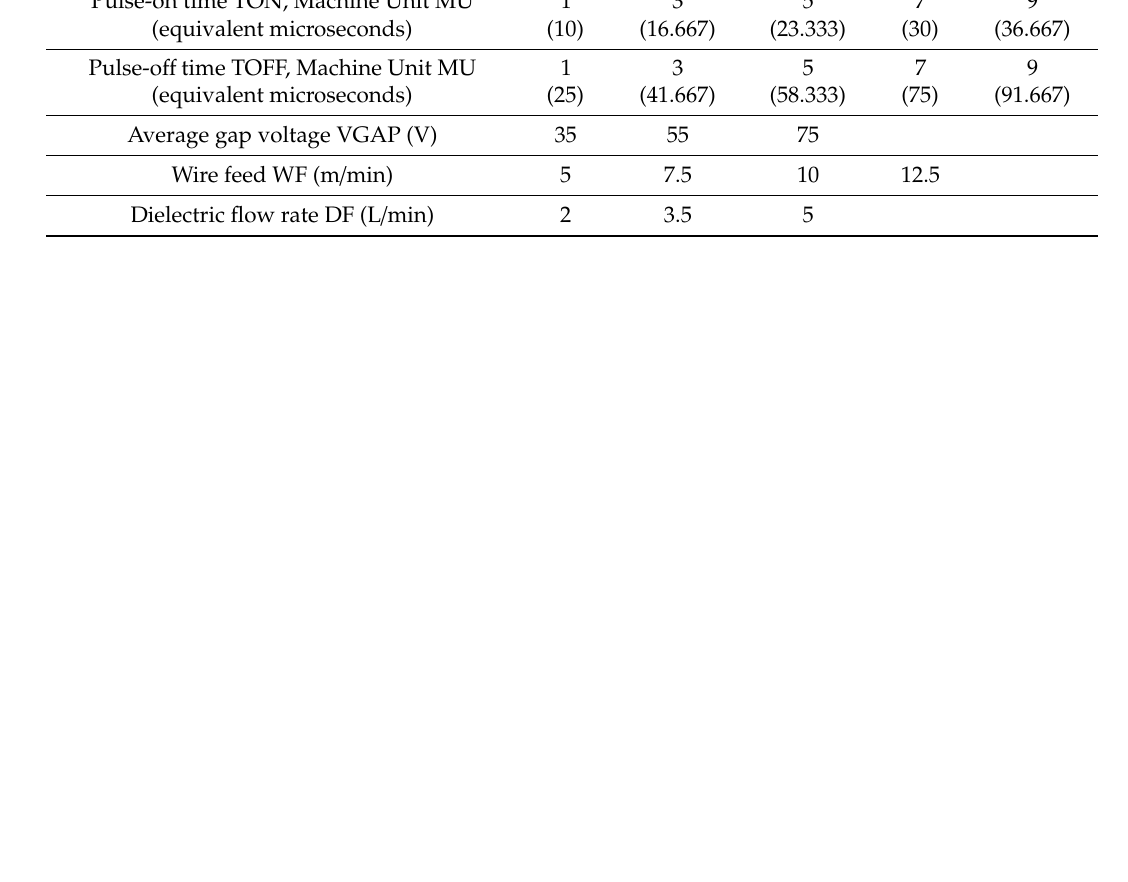
Table 3. Wire electrical discharge machining (WEDM) process factors and their respective levels.